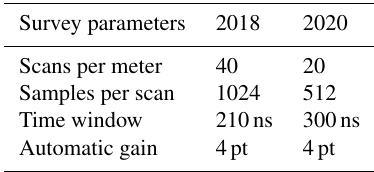
Table 1. GPR settings of the measurements. Survey